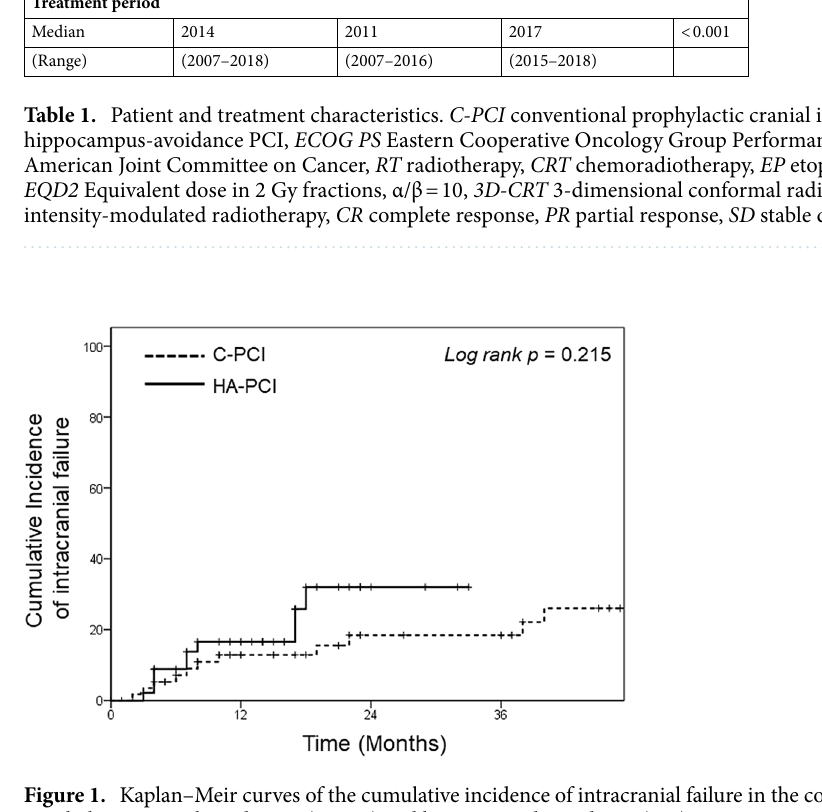
Figure 1. Kaplan–Meir curves of the cumulative incidence of intracranial failure in the conventional prophylactic cranial irradiation (C-PCI) and hippocampal-avoidance (HA)-PCI groups.